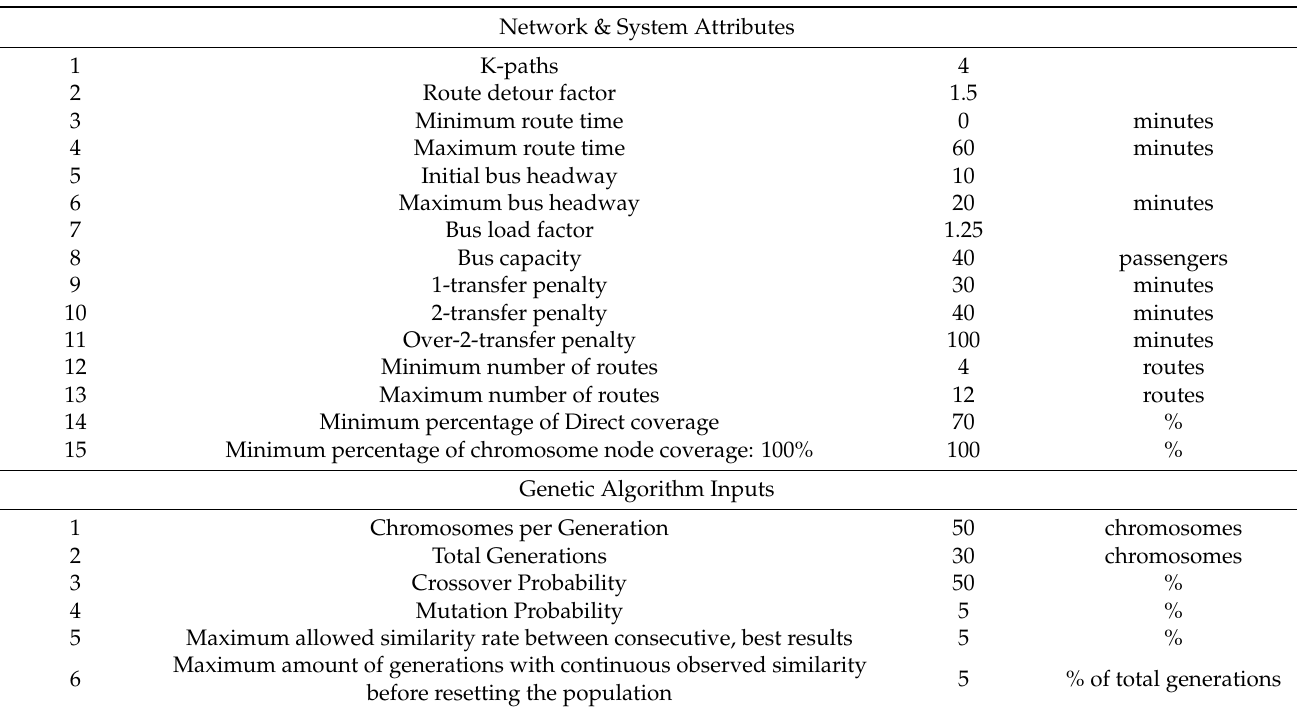
Table 2. Algorithm